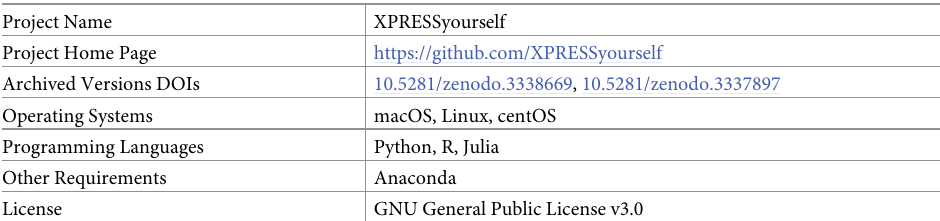
Table 3. Software